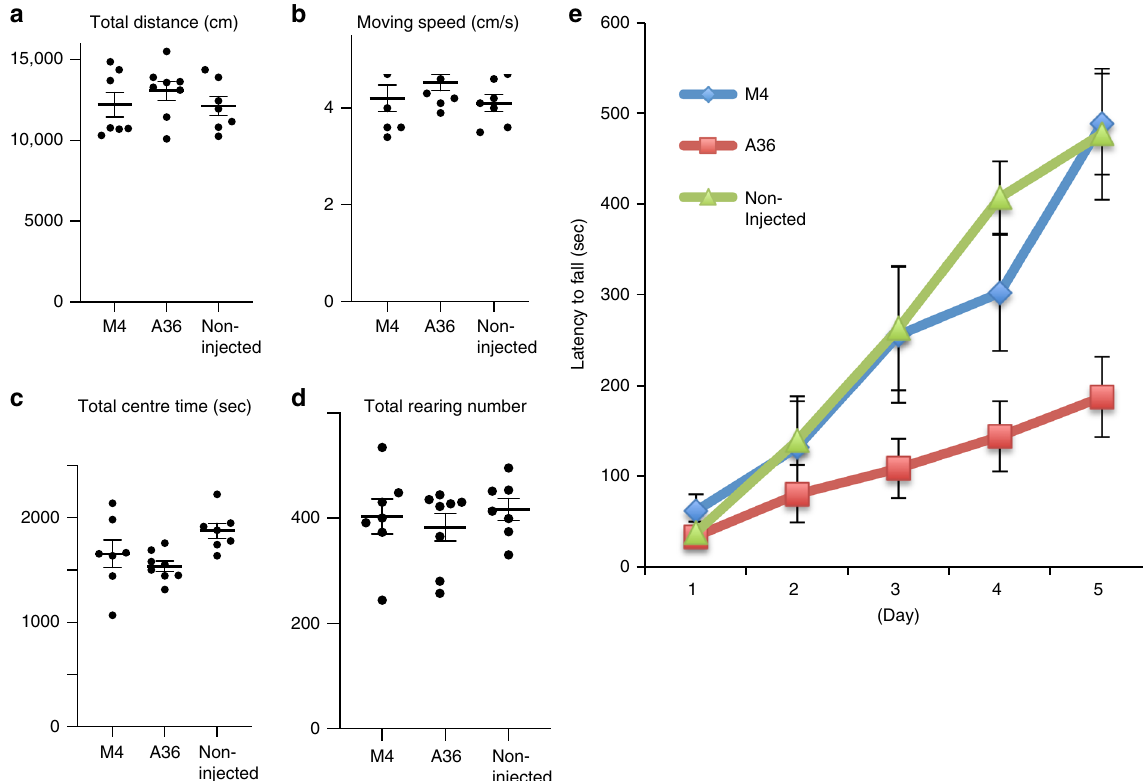
Fig. 8 STAND-A36 impairs motor-skill learning. a – d Open- fi eld test. Total distance travelled a , moving speed b , total time spent in the centre of the fi eld c , and total number of rearings d are shown. e Rotarod test. Latency to fall is shown. Statistical analysis in a – d ; two-tailed one-way ANOVA: Total distance, F (2, 19) = 0.6885, P = 0.51441; moving speed, F (2, 19) = 1.19321, P = 0.32476; total number of rearings, F (2, 19) = 0.40367, P = 0.67345; total centre time, F (2, 19) = 3.79839, P = 0.04095, Tukey ’ s multiple comparison test, A36 vs. non-injected, P = 0.033782; A36 vs. M4, P = 0.612174; M4 vs. non- injected, P = 0.223909. Statistical analysis in e ; two-tailed two-way ANOVA: interaction, F (8, 76) = 2.890, P = 0.0072677; gene, F (2, 19) = 6.208, P